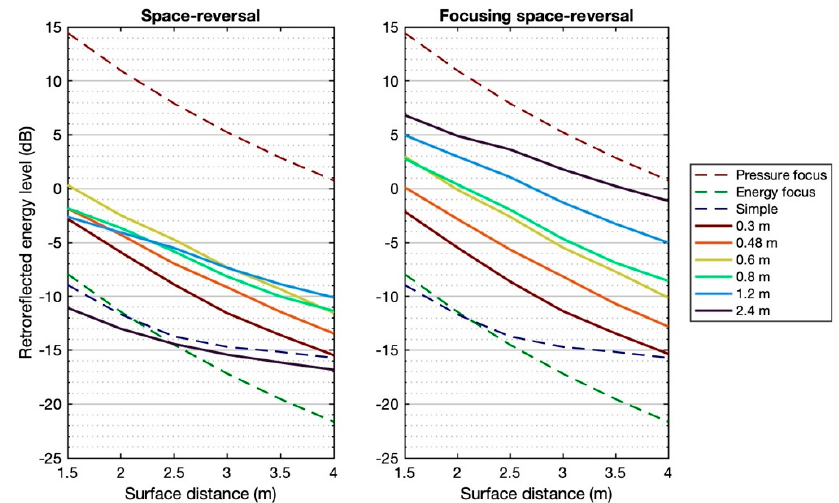
Figure 12. Spatially averaged retroreflected energy levels at collocated source-receivers for space- reversal and focusing space-reversal surface configurations. Twenty-five source-receivers are lo- cated within a 2.4 × 2.4 m square offset from a 2.4 × 2.4 m reflector. Distances from source- receiver to reflector are indicated by the x -axis. Dashed lines show theoretical expectations. Values are speech-A-weighted.